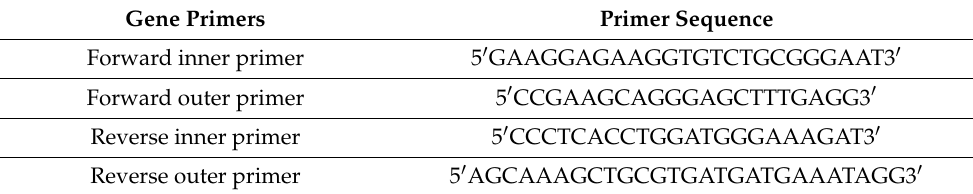
Table 1. The Primer Sequence of MTHFR Variant C677T (rs1801133).